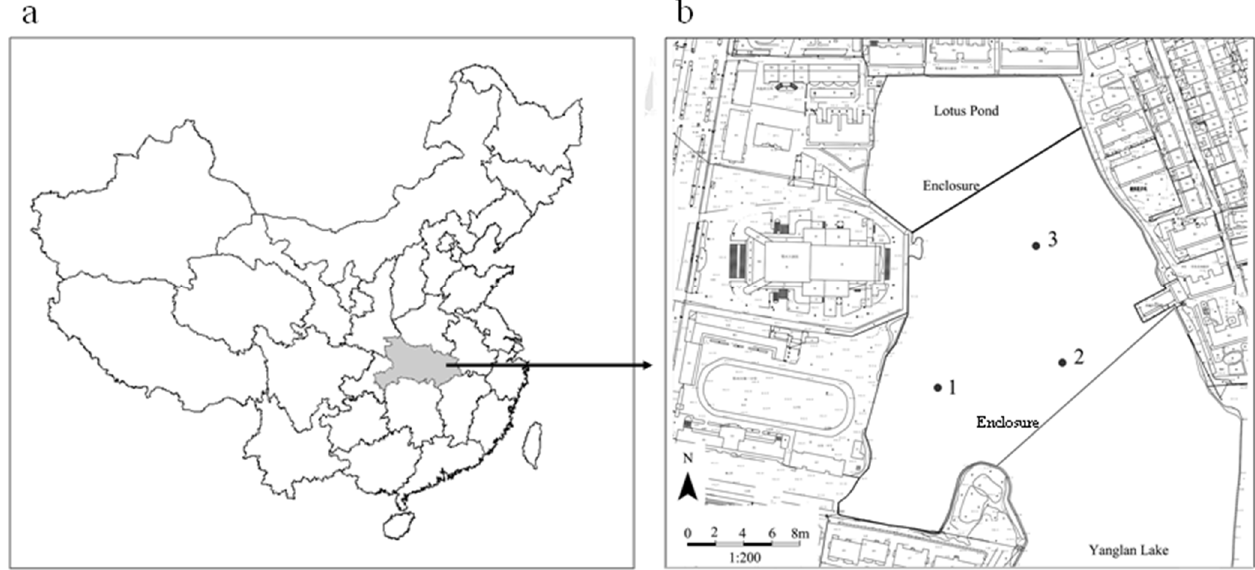
Figure 1. Location of Lake Yanglan ( a ) and the sampling sites ( b ) in the experimental area (sites 1–3).